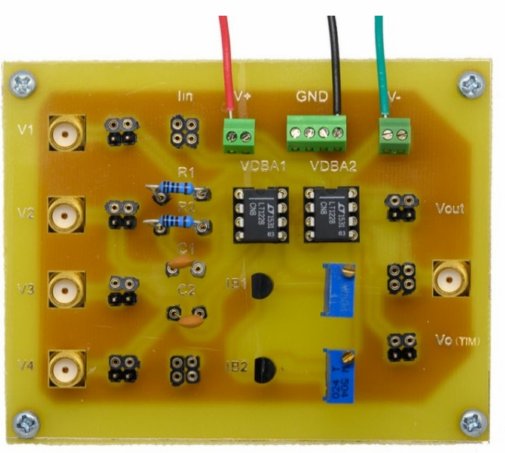
Figure 16. PCB of Figure 3 used for experimental verification.